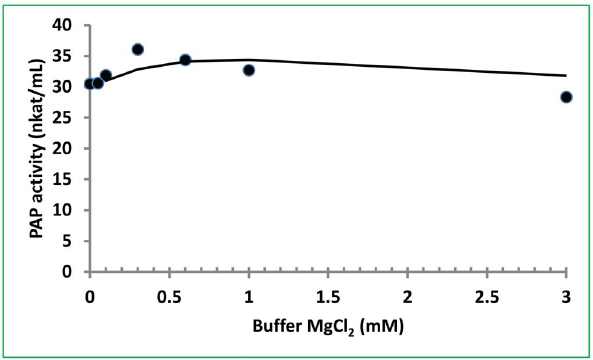
Figure 5. Effect of Mg 2 + on PAP activity catalyzing PtdOH. The assay was performed at 53 u C, pH 6.5 for 30 min using 5 m L of the PAP preparation with 500 m M DPA and various concentrations of MgCl 2 . The data presented are the mean of 2 assays for each sample.